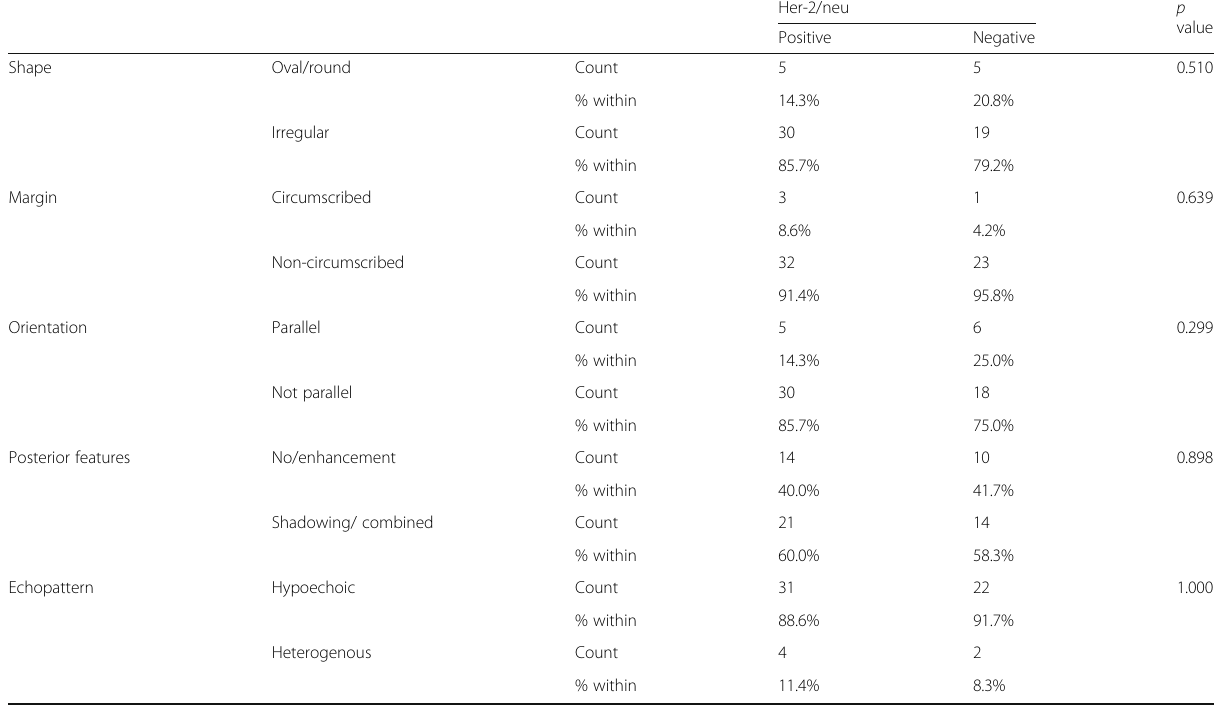
Table 6 Association between status of Her-2/neu and ultrasound findings of breast cancer